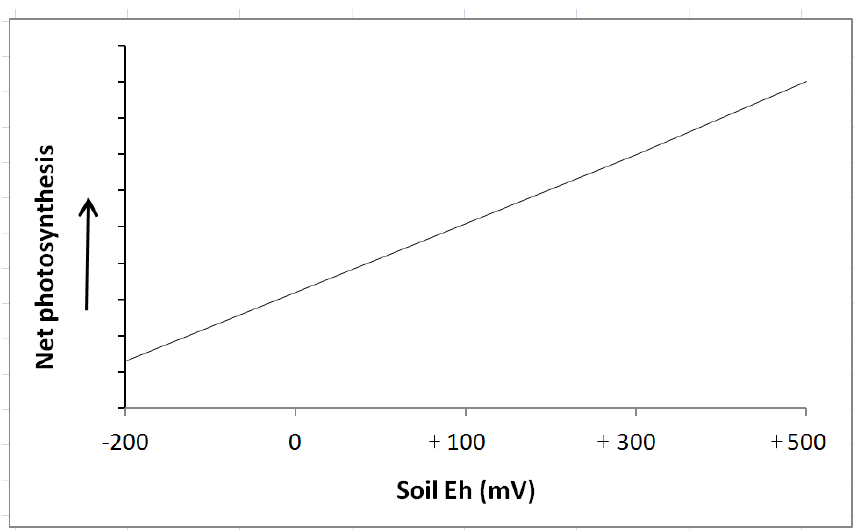
Figure 6. A generalized relationship between photosynthetic activity in wetland plants and soil redox potential (from Pezeshki [22,23]).